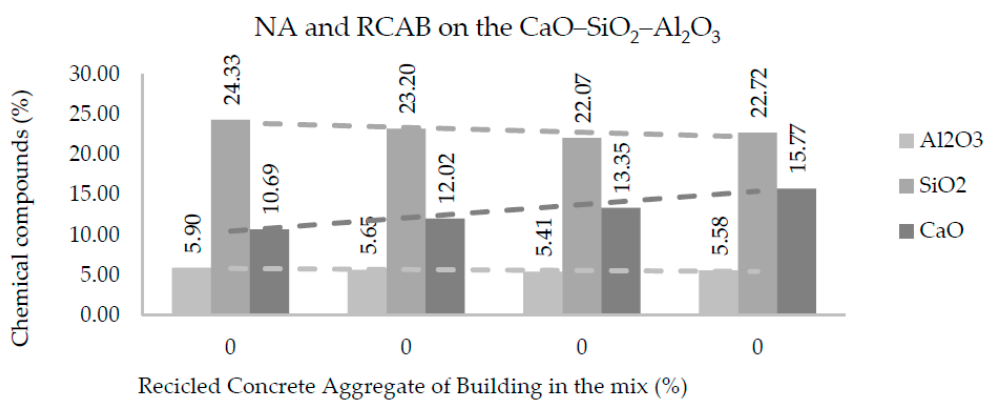
Figure 11. Effects of RCAB percentage on Al 2 O 3 , SiO 2 , and CaO contents in the mixtures of aggregates.